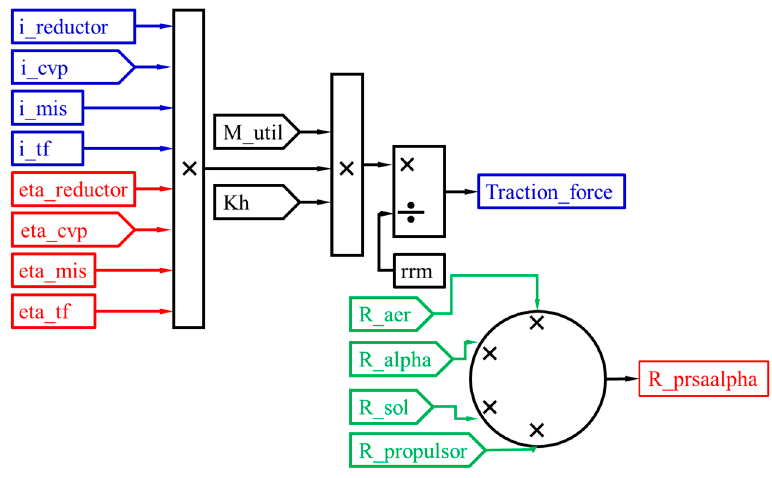
Figure 10. Modeling of traction force and forward resistance forces.